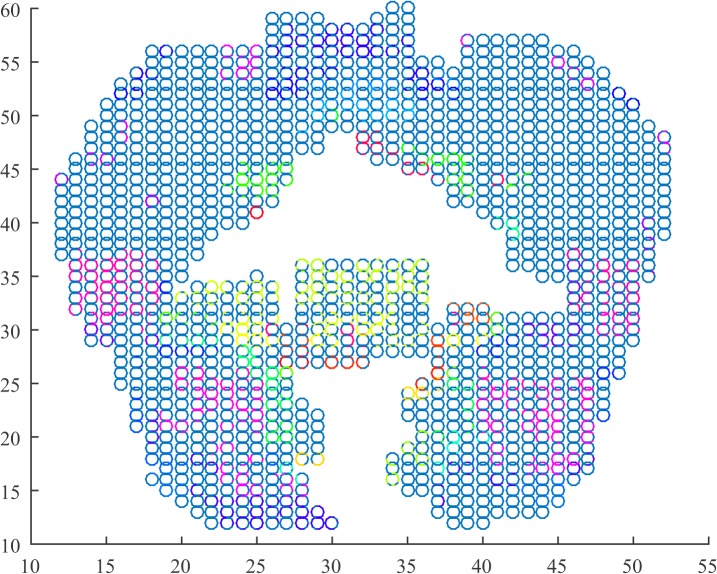
Cluster depiction in the coronal view (z = 0) of the cortex during blank screen.Clusters identified by the regularity partitioning algorithm as seen on the coronal view obtained by the examined fMRI data. Each cluster is colored with a different color. During this epoch, the subject was not exposed to a stimulus. Clusters seem to appear in the temporal and frontal lobes.